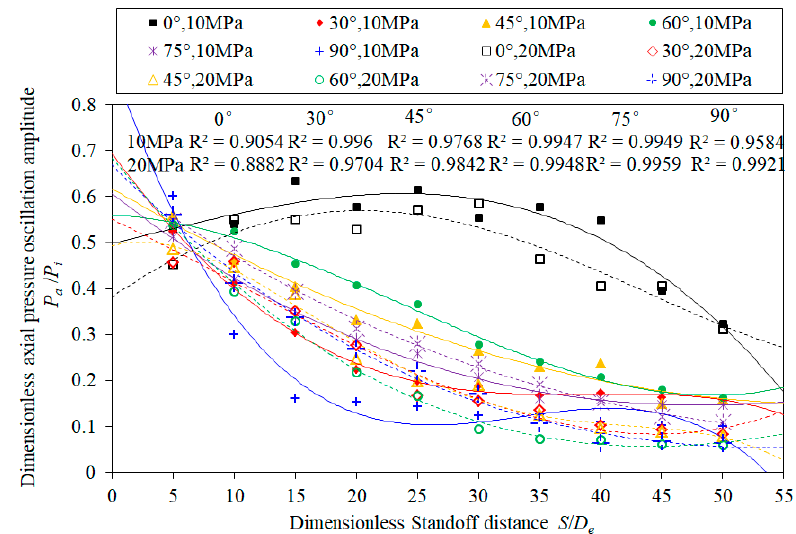
Figure 8. The dimensionless pressure oscillation amplitude against dimensionless standoff distance.